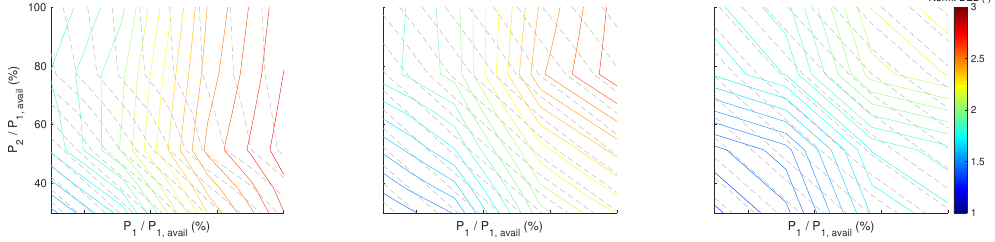
Figure 9. Impact of wind conditions and turbine power set-points on simulated sum TBFA damage equivalent loads of two turbine array. Contour lines show sum TBFA loads normalised by the load of upstream turbine in default wind conditions. Grey dashed lines denote contours of same sum power output of turbine array. Wind direction is 0, 10 and 22 degrees from left to right. Default wind conditions are mean wind speed of 8 m/s, turbulence intensity of 7%, and wind direction of 0 degrees, in which direction is aligned with turbine array. The distance between the turbines is 5D.